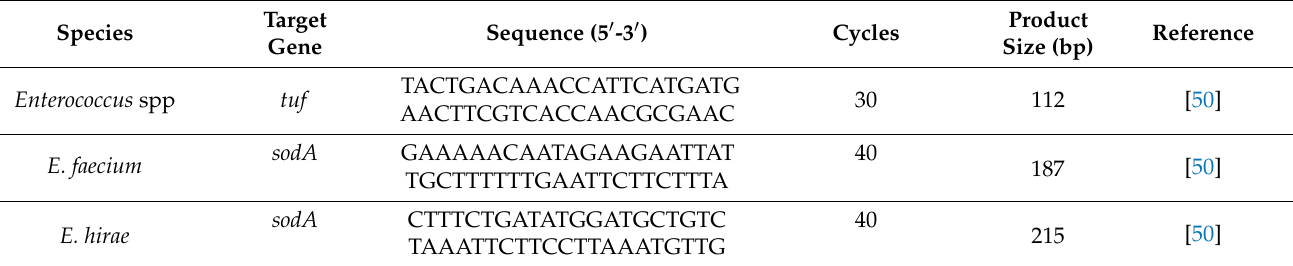
Table 1. Primer sequences for Enterococcus spp, E. faecium and E. hirae